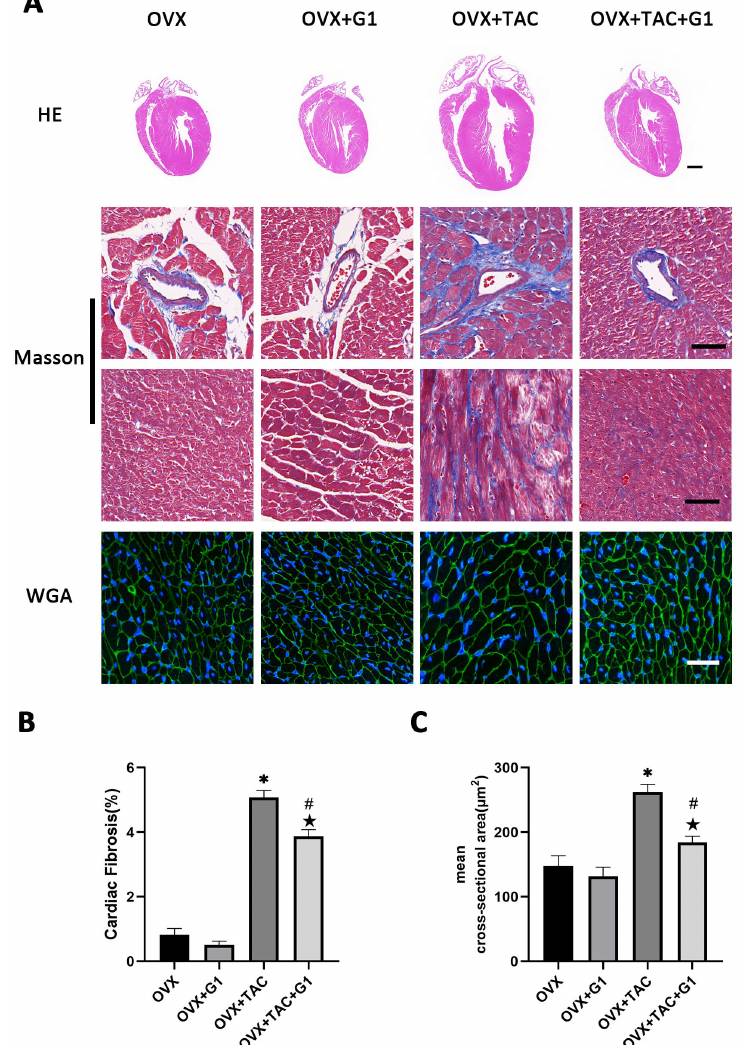
Figure 3. G1 alleviated cardiac hypertrophy and fibrosis of mice in the OVX + TAC group. ( A ) Representative images of cardiac sections for HE (scale bar = 1 mm), Masson and WGA staining (scale bar = 50 µm) in four groups. ( B ) Cardiac fibrosis ratio in different groups. ( C ) Mean cross-sectional area of cardiomyocytes in each group. The data is expressed as mean ± SEM and analyzed by one-way ANOVA (n = 4). * p < 0.05 vs. Sham; # p < 0.05 vs. TAC; (cid:70) p < 0.05 vs.